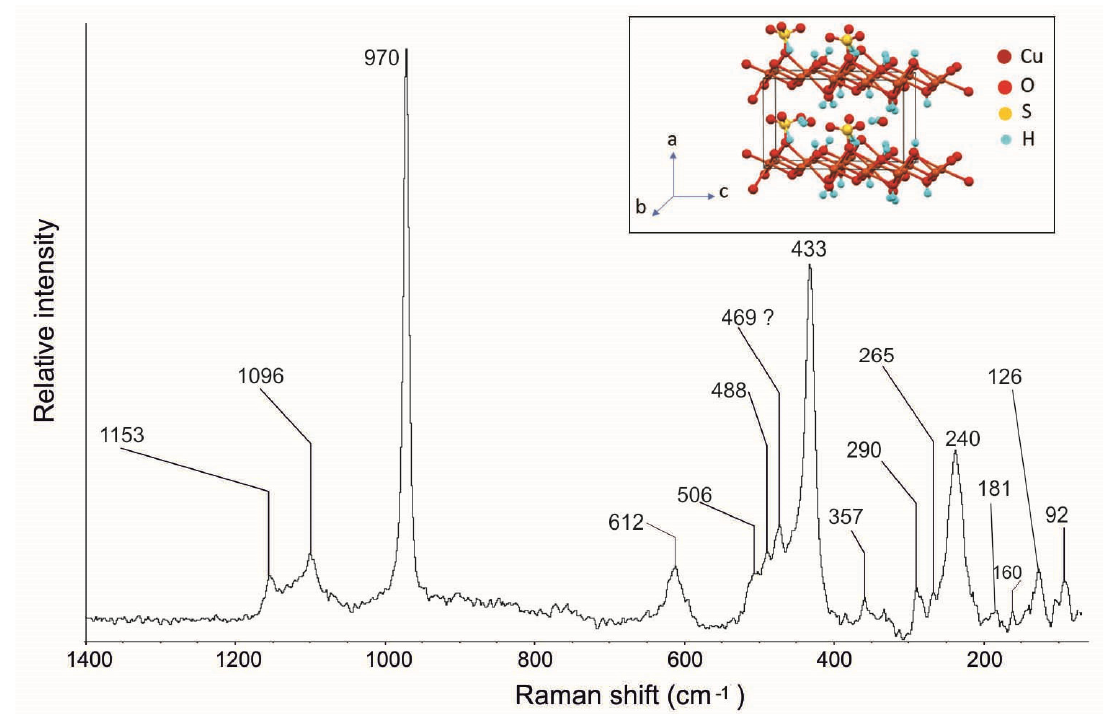
Figure 13. Raman spectrum of langite crystals from the Mastricarro Barite Mine (Catanzaro, south- ern Italy). In the insert is the structure of the langite [40,46].